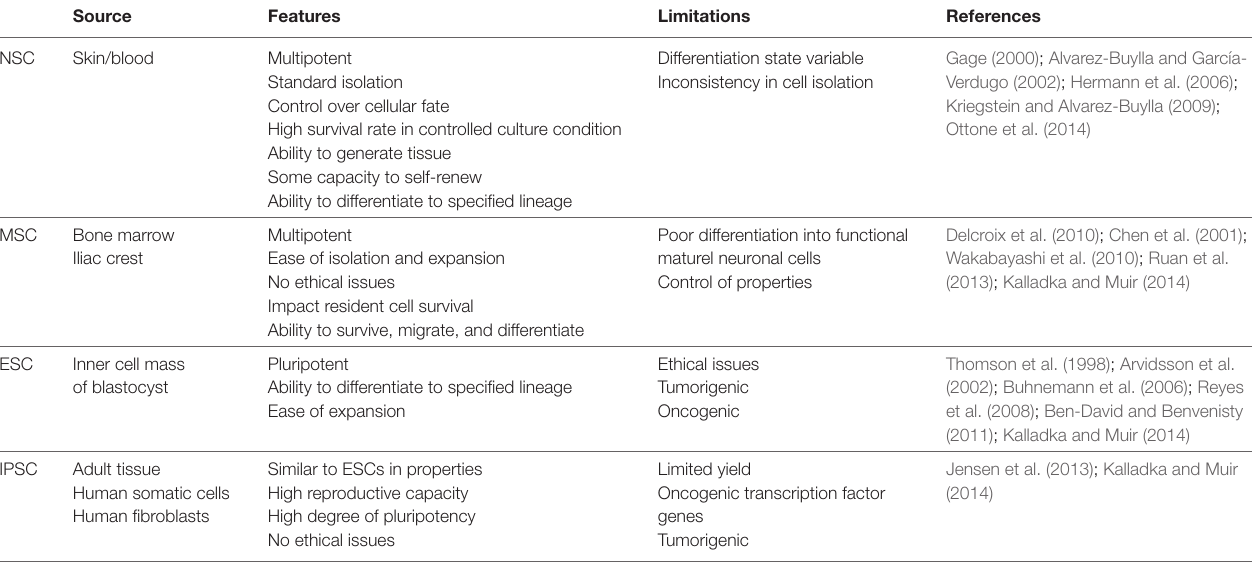
TABLe 1 | A summary of neural stem cell (NSC), mesenchymal stem cell (MSC), embryonic stem cell (ESC), and induced pluripotent stem cell (IPSC) isolation sources, advantages, and